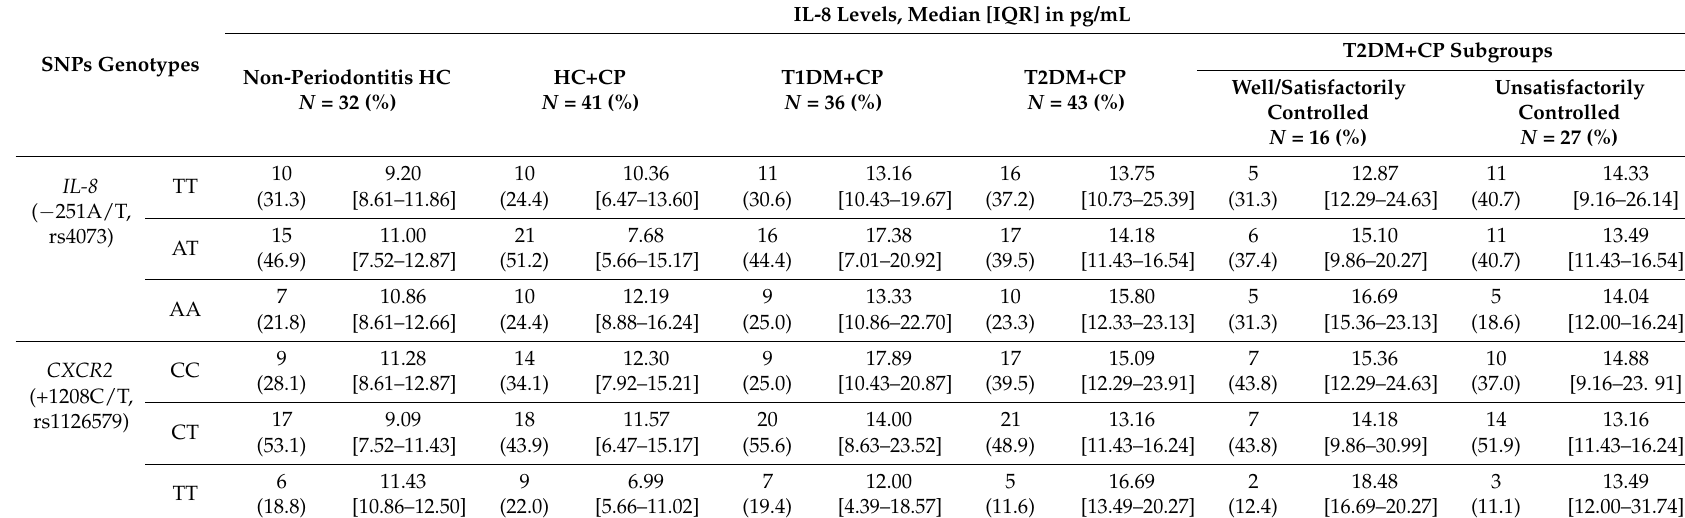
Table 4. IL-8 plasma levels and polymorphisms in IL-8 and CXCR2 genes